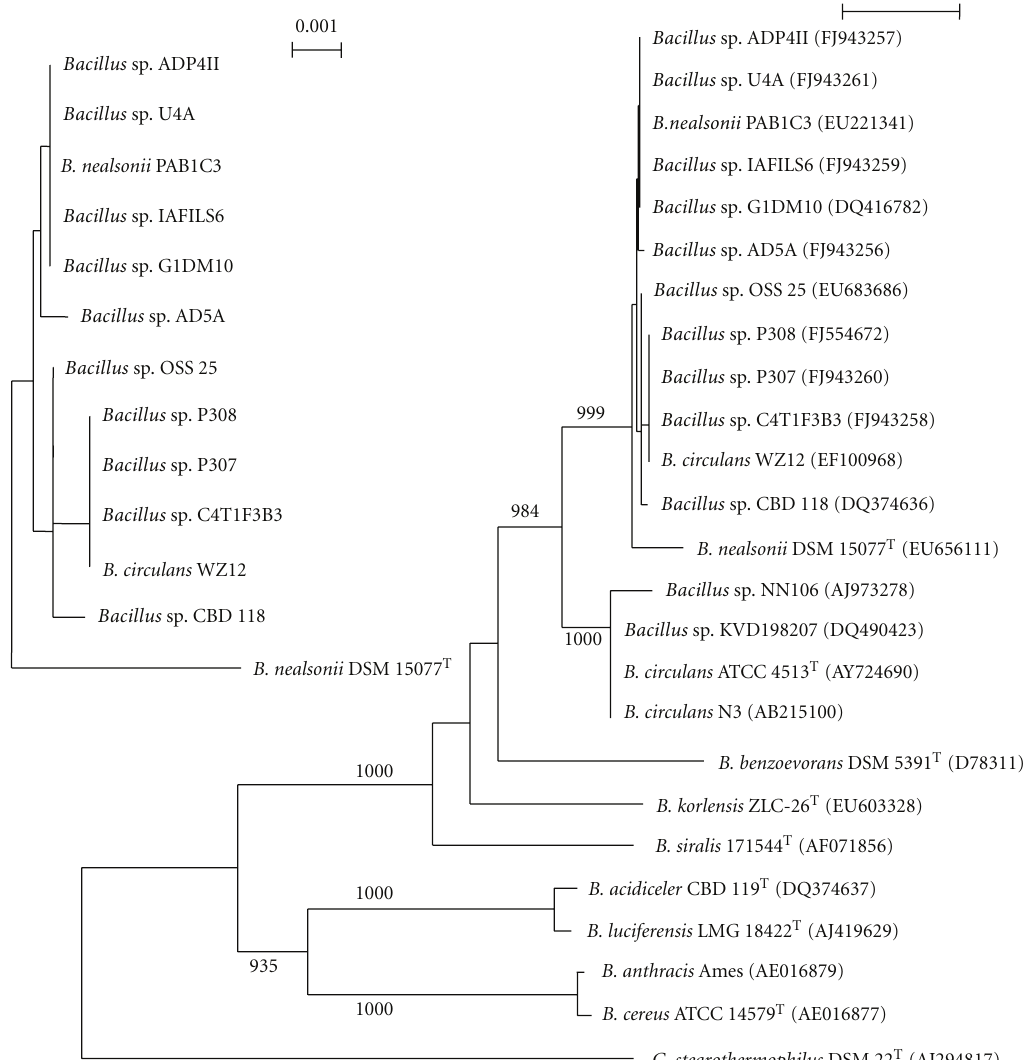
Figure 1: Phylogenetic relationship of strain CBD 118 with type strains of other Bacillus spp. and with strains from GenBank with highest similarities (accession numbers in parentheses). The Neighbor-Joining tree and subtree are based on approximately 1390 bp of the 16S rRNA gene. Numbers show the level of bootstrap support from 1000 repetitions with only those > 750 shown. Bars, nucleotide substitutions per